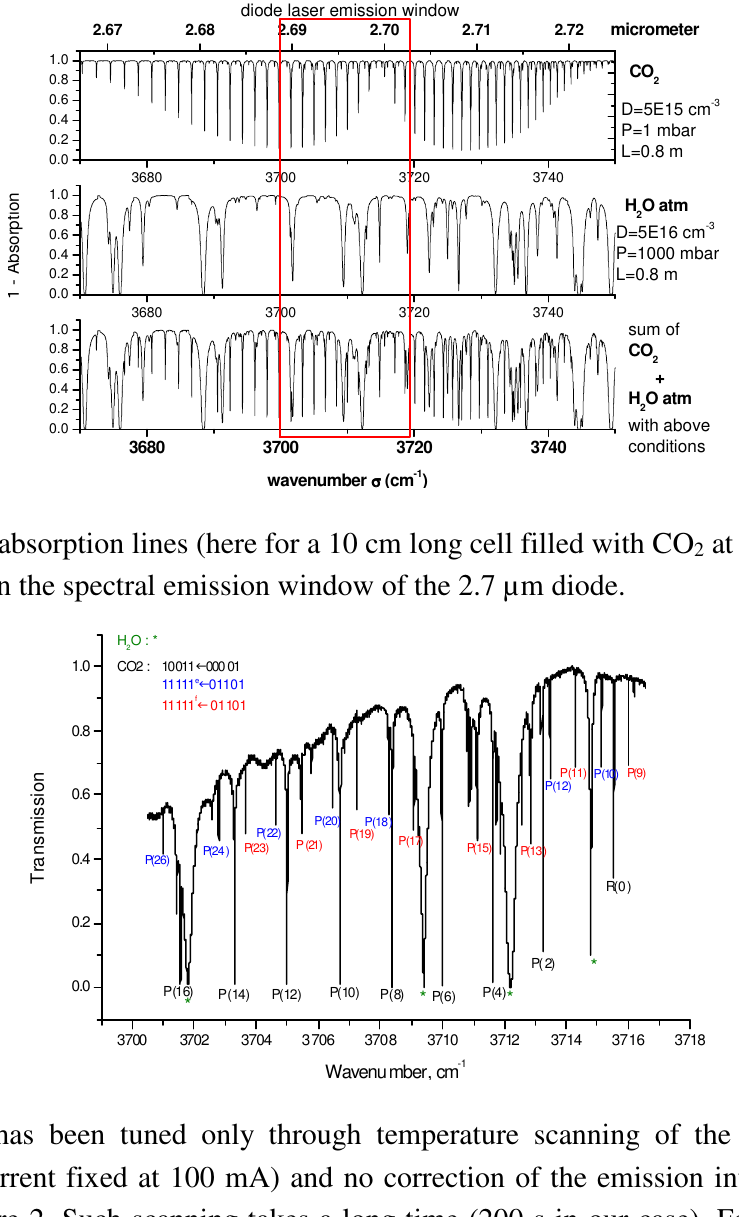
Figure 1. Diode laser emission window matched to low pressure CO atmospheric H O absorption lines in the 2.7 µm spectral region. The simulations are 2 performed at values of density D, pressure P and absorption length L indicated in the figure.